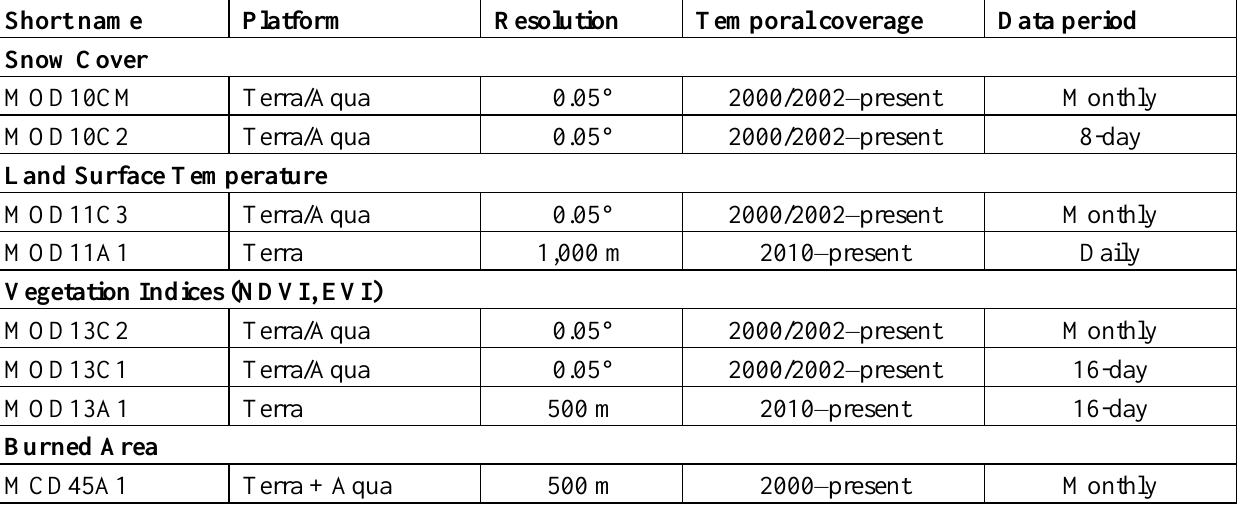
Table 8. Automatic integrated products from MODIS sensor. EVI, enhanced vegetation